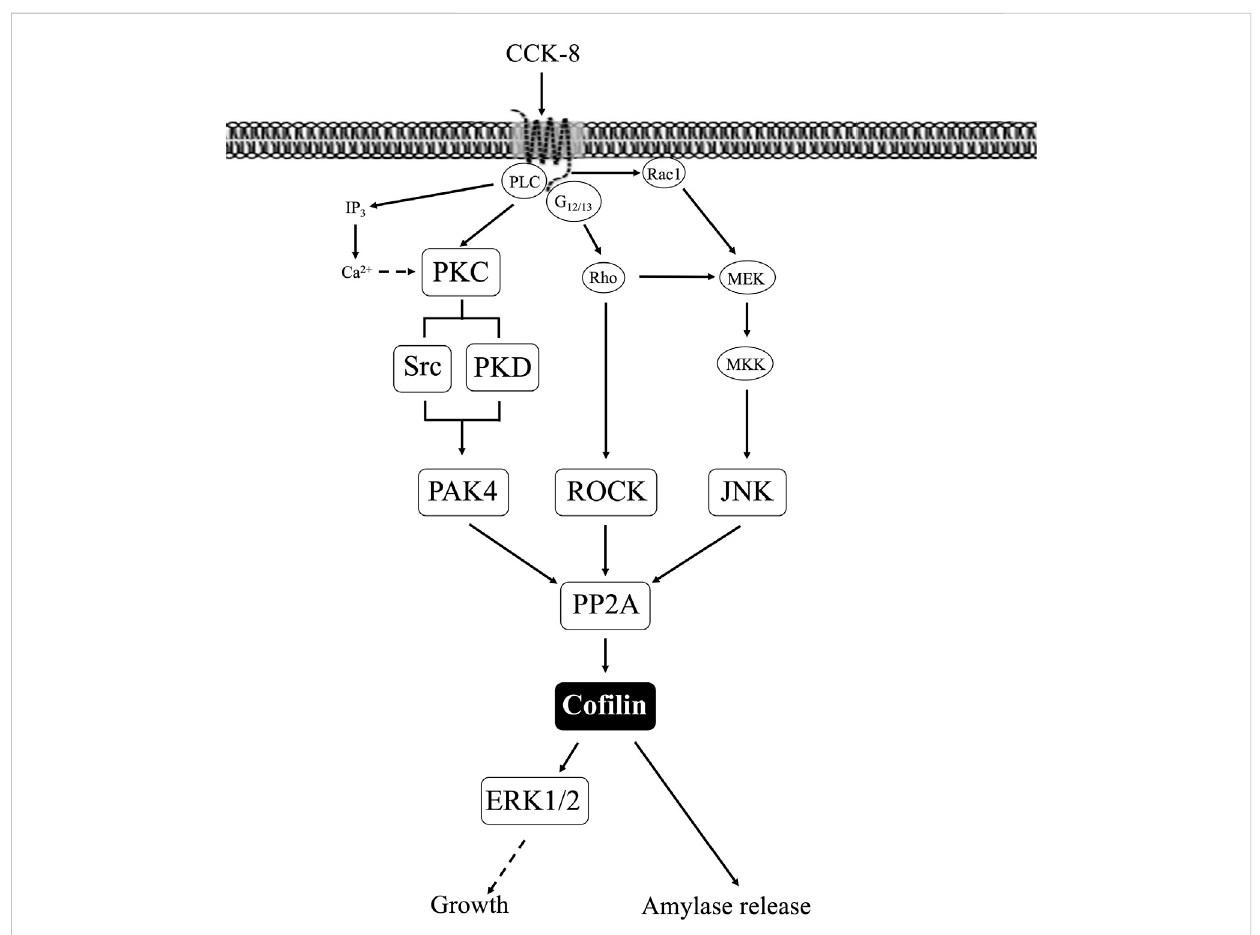
FIGURE 14 Schematic diagram of signaling cascade for activation of co fi lin in pancreatic acinar cells. In rat pancreatic acinar cells, maximal activation of co fi lin by cholecystokinin (CCK)-8 requires activation of PKC, which mediates both Src family of kinase (SFK) and protein kinase D (PKD) activation resulting in PAK4 activation; requires activation of ROCK, which is mediated by Rho; requires activation of JNK, mediated by activation of this MAPK pathway; and requires activation of serine protein phosphatases (PP2A), which are a substrate of PKC. Co fi lin activation is important for CCK-stimulated enzyme secretion as well as ERK1/2 activation which has been shown to mediate growth. Squares represent signaling pathways shown to be involved in co fi lin activation in this